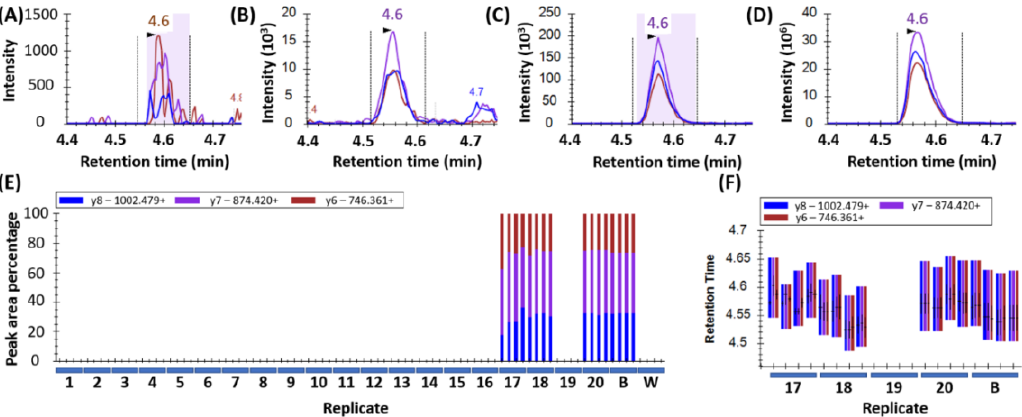
Figure 5. Barley peptide (VFLQQQCSPVR from B-hordein, UniProt: I6SJ22) peak detection in yeast samples: ( A ) sample 17 (intensity 1.2 × 10 3 ); ( B ) sample 18 (intensity 1.7 × 10 4 ); ( C ) sample 20 (intensity 2.0 × 10 4 ); and ( D ) barley (control, intensity 3.4 × 10 7 ). The peaks were detected using three MRM transitions per peptide and the ratio of these as shown in ( E ) by blue / purple / brown bars act as a quality control (QC) factor for peak detection. A second QC factor was the co-elution of the transitions at the retention time of the control barley ( F ).